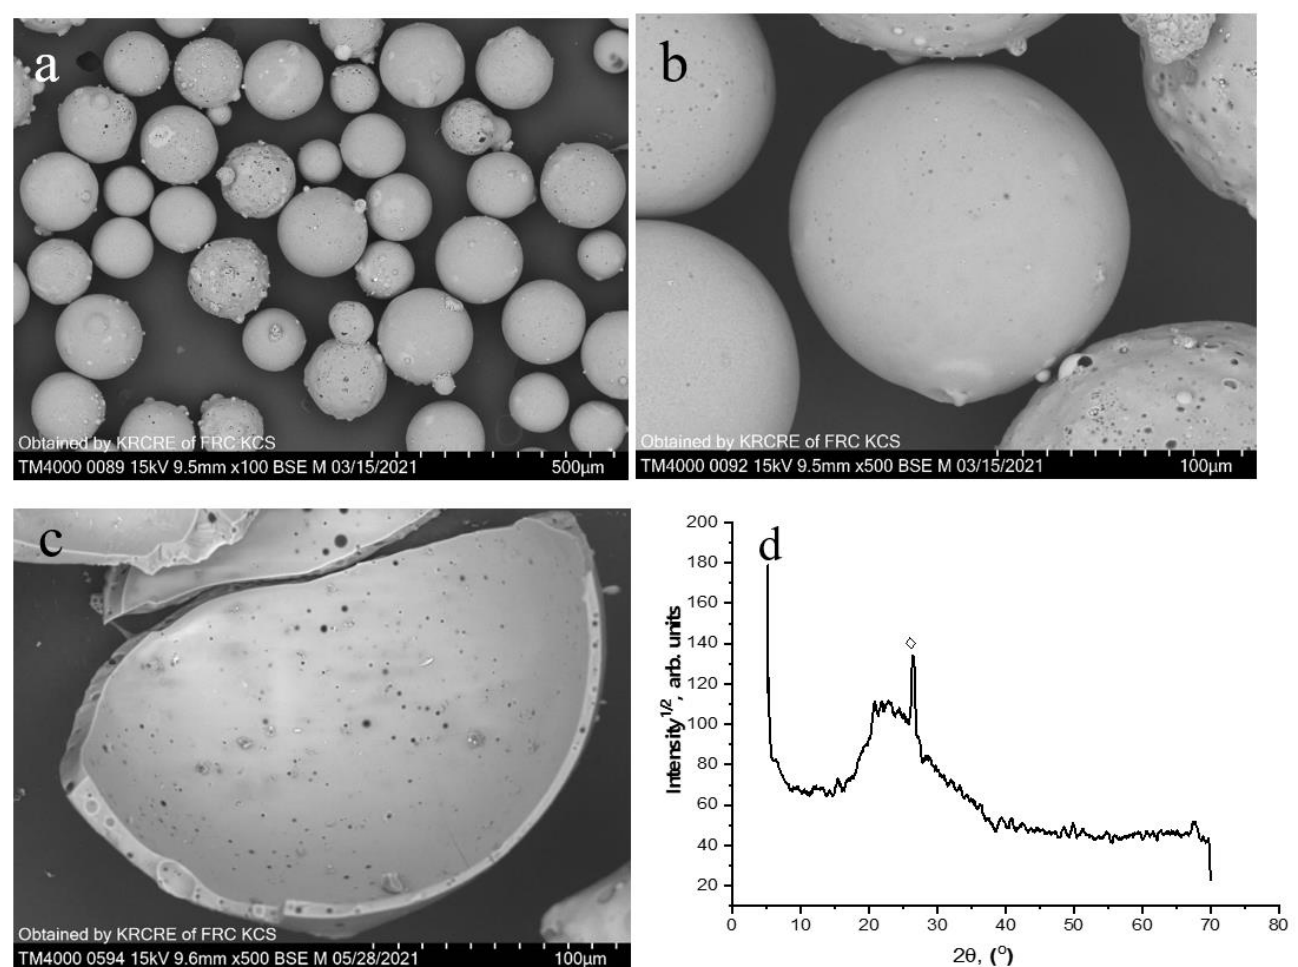
Figure 1. SEM images of initial cenospheres ( a , b ) and broken cenosphere globule ( c ); PXRD pattern of the cenospheres ( d ) ( ♦ —quartz).